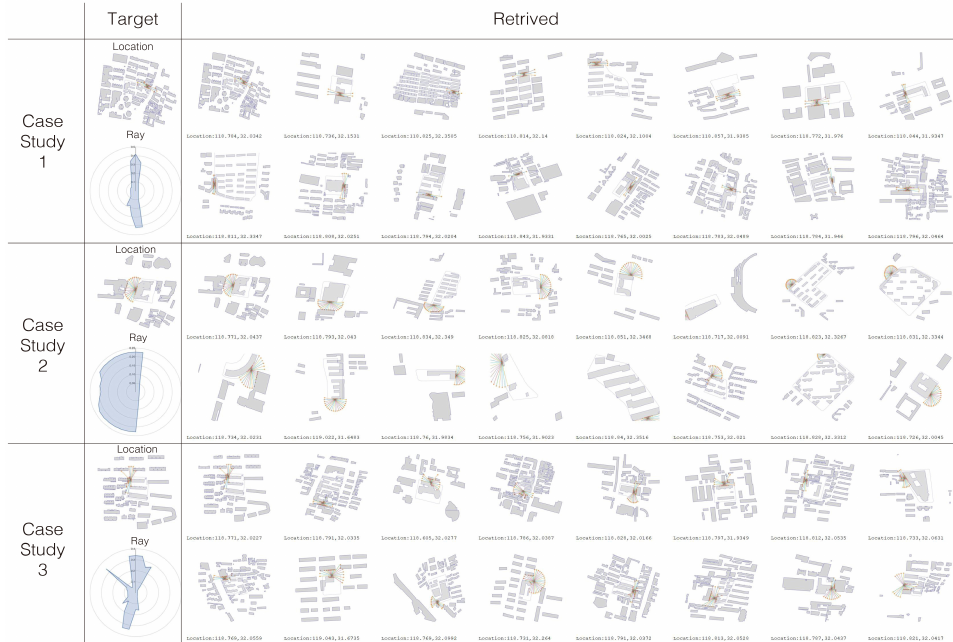
Figure 10. Locations in similar spatial traits are retrieved according to geometric features.